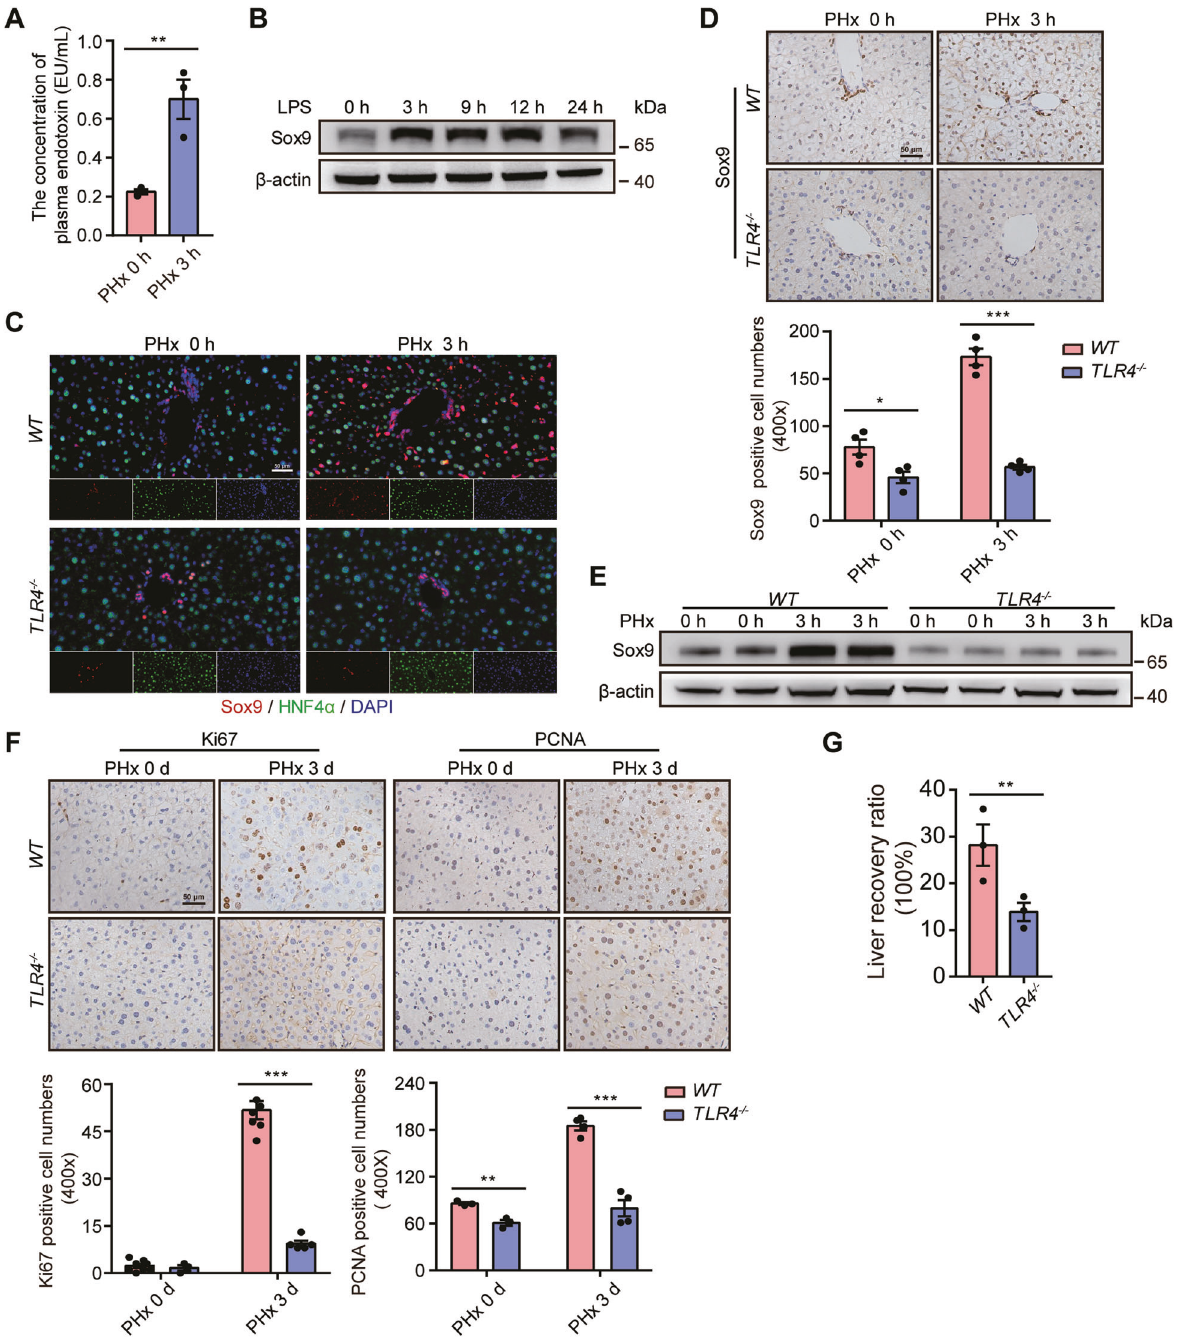
Fig. 2 The LPS/TLR4 signaling pathway induces the transition of hepatocytes into Sox9 + HNF4 α + cells and promotes liver regeneration. ( A ) The levels of plasma LPS from the portal vein in the control and PHx groups at 3 h post-surgery. ( B ) The relative expression of Sox9 was assessed by western blotting in AML12 cells after stimulation with LPS for the indicated times. ( C ) Double staining of liver sections for Sox9 (red) and HNF4 α (green) at hours 0 and 3 after PHx in wild-type and TLR4 -/- mice. ( D ) Upper: Representative Sox9 staining in wild-type and TLR4 -/- mice after PHx. Bottom: Quanti fi cation of Sox9-positive cell numbers. ( E ) Representative western blotting analysis of Sox9 in wild-type and TLR4 -/- mice after PHx. ( F ) Upper: IHC analysis of Ki67 and PCNA in liver tissue after PHx in wild-type and TLR4 -/- mice. Bottom: Quanti fi cation of Ki67- or PCNA-positive cells. ( G ) Liver recovery ratio in wild-type and TLR4 -/- mice at 3 days after PHx. The data are expressed as the mean ± SEM. The measurement results were repeated at least 3 times and the results were similar. * p < 0.05, ** p < 0.01, and *** p <